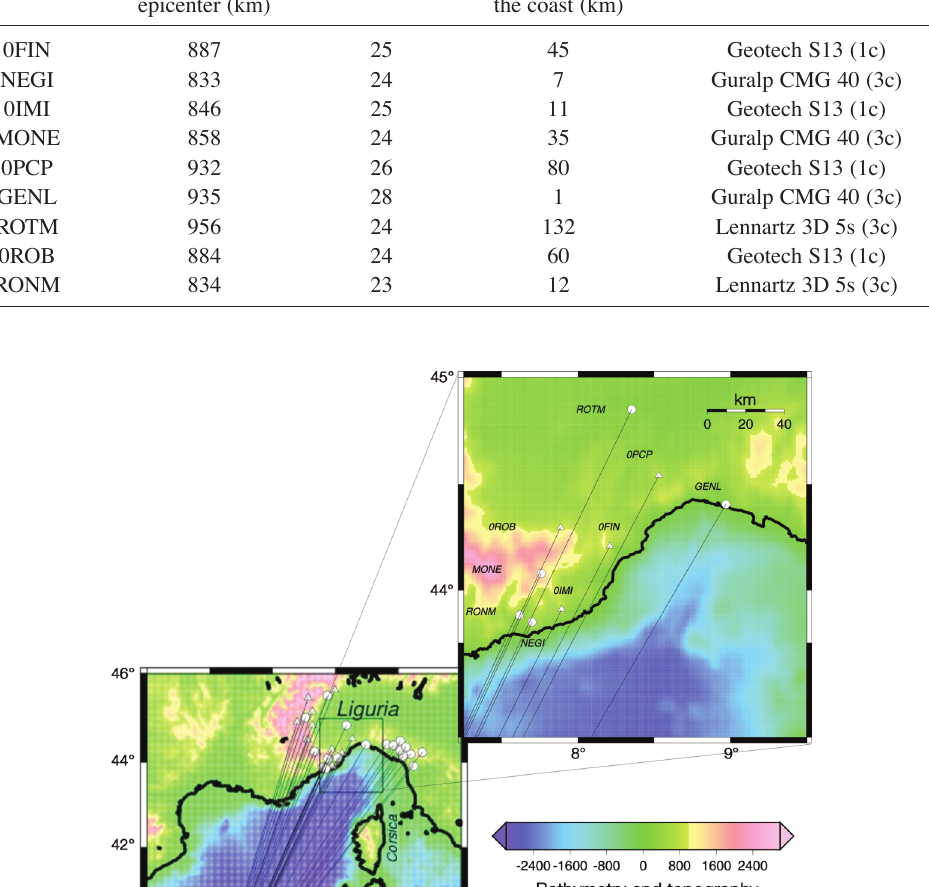
Table I. Location (distance and azimuth) and instrumentation of the seismic stations used in this work. The distance from the coast computed on the incoming path is also reported. Station code